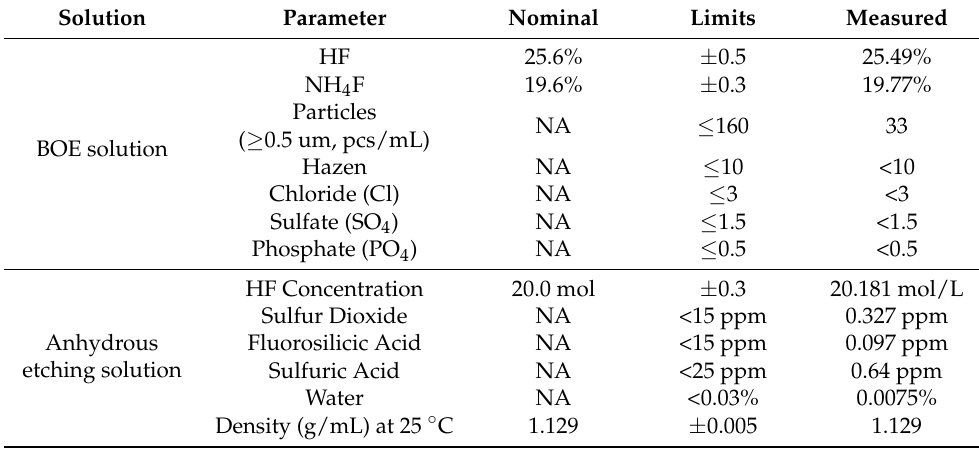
Table 1. Composition and concentration of BOE solution and anhydrous etching solution.